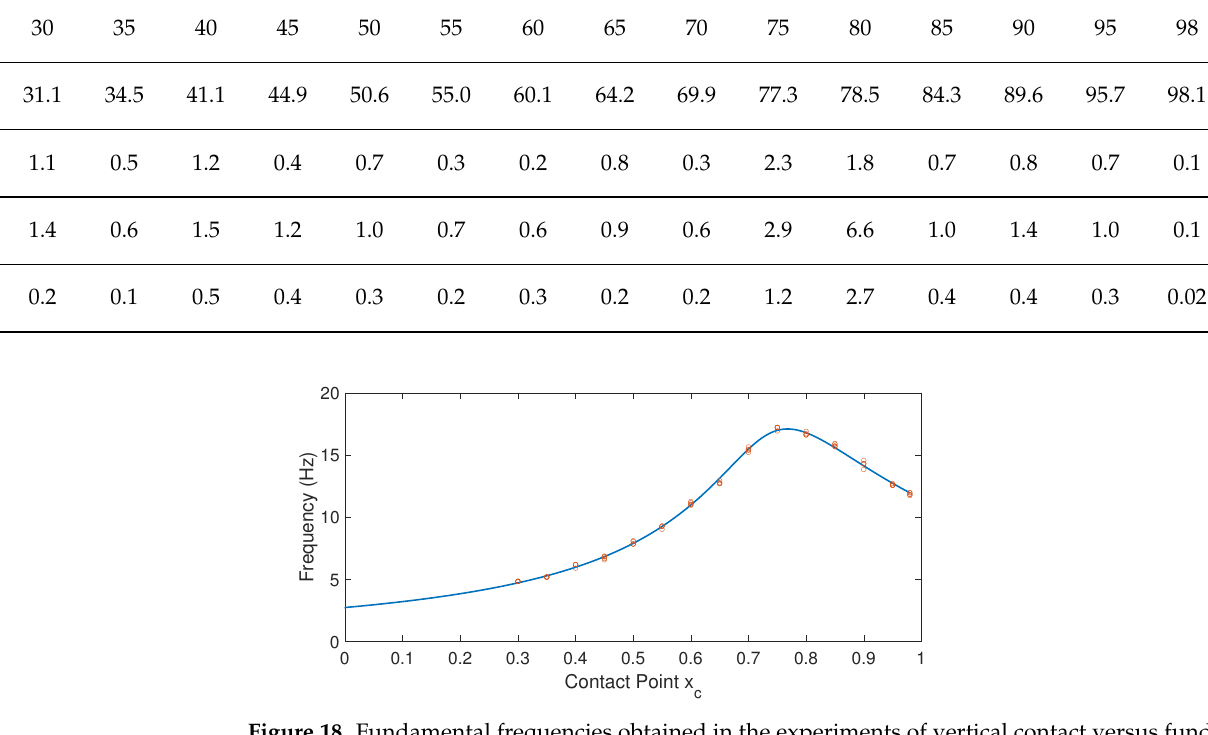
Figure 18. Fundamental frequencies obtained in the experiments of vertical contact versus funda- mental frequencies provided by the model (3) of azimuthal